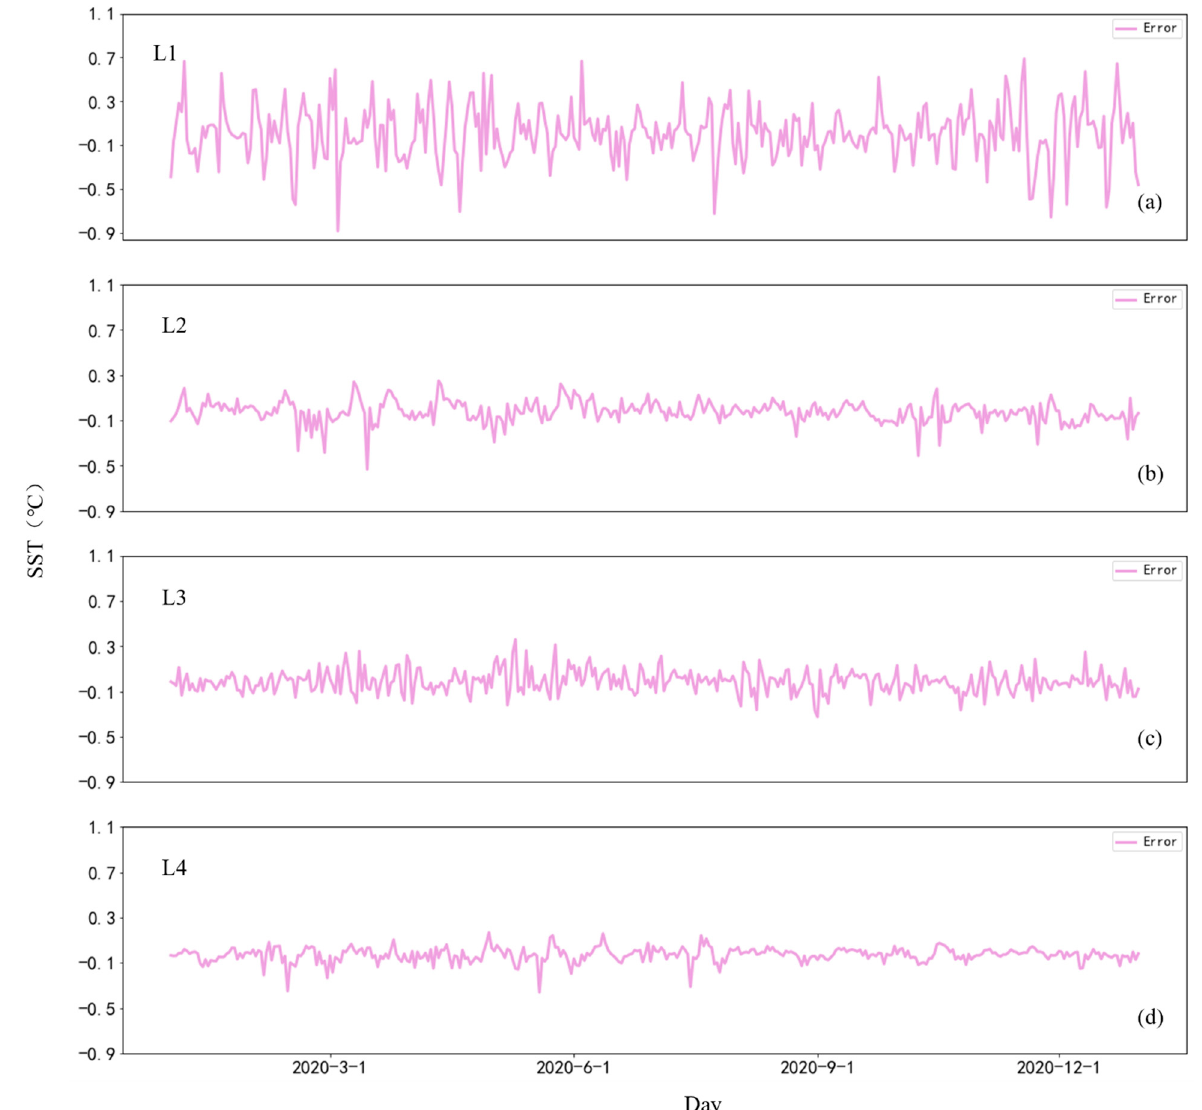
Figure 6. The error of OSTIA data and LSTM prediction results at different points, where the error is obtained by subtracting the OSTIA data and the LSTM prediction result. ( a – d ) are the errors of L1, L2, L3 and L4, respectively. The abscissa is SST in degrees Celsius, and the ordinate is the number of days.